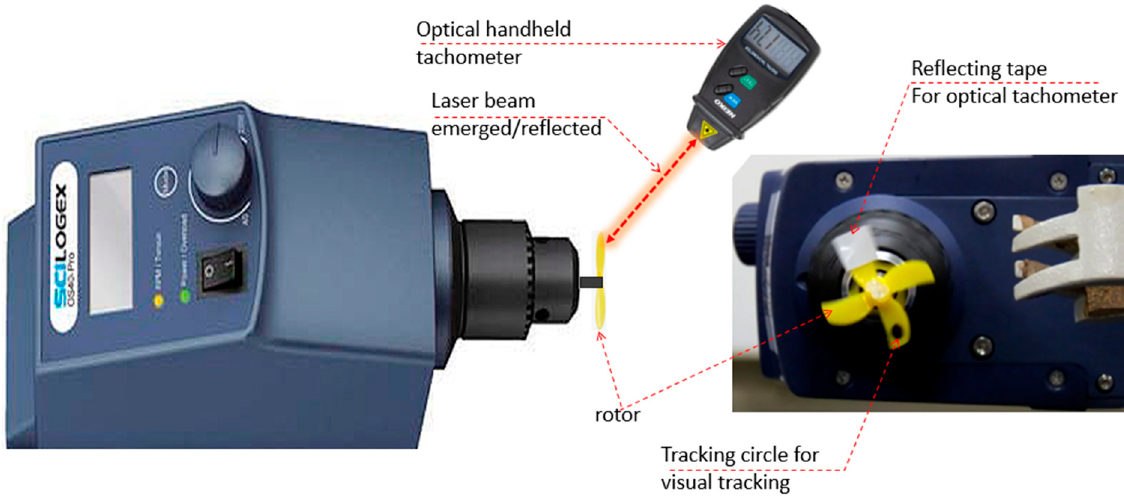
Figure 4. Setup of the assessment of accuracy experiments (using two different methods) for the angular speed measurements: oblique-plan view, side